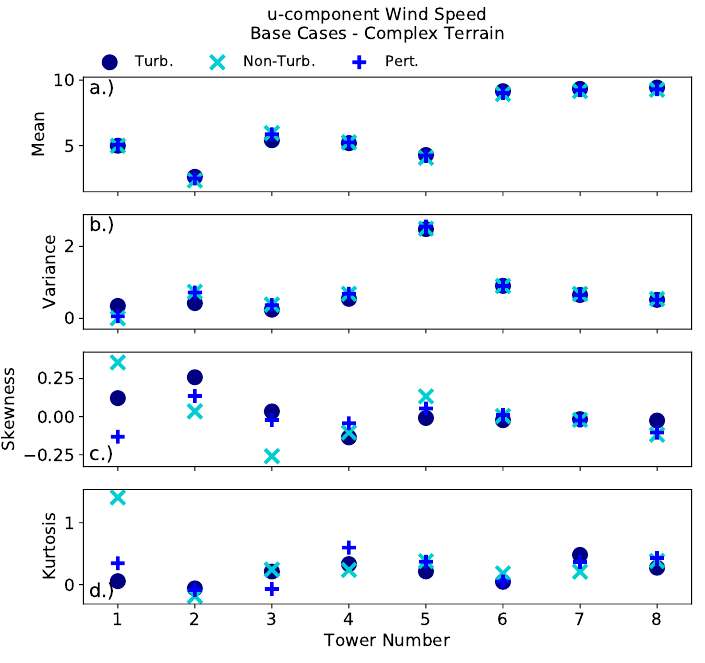
Figure 6. The tower line average mean ( a ), variance ( b ), skewness ( c ), and kurtosis ( d ) for each of the eight tower lines calculated from the time series of the u -component winds at 110 m in the CXT_base